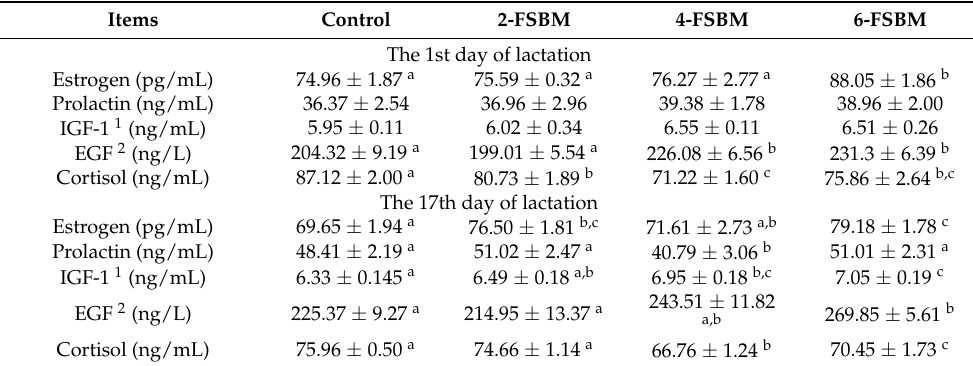
Table 5. The levels of estrogen, prolactin, IGF-1, and EGF in the serum of sows.